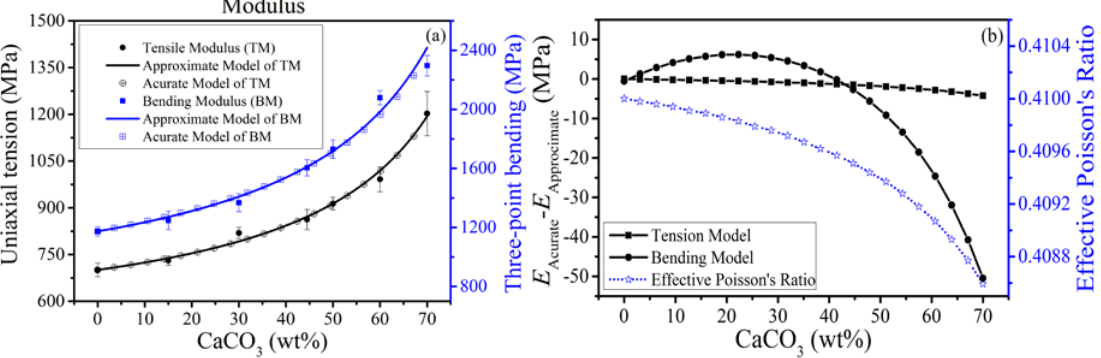
Figure 5. ( a ) Variation tendencies of moduli; ( b ) comparison of two isotropic models and the variation tendency of effective Poisson's ratio. Table 1. The values of fitting parameters of two isotropic models.